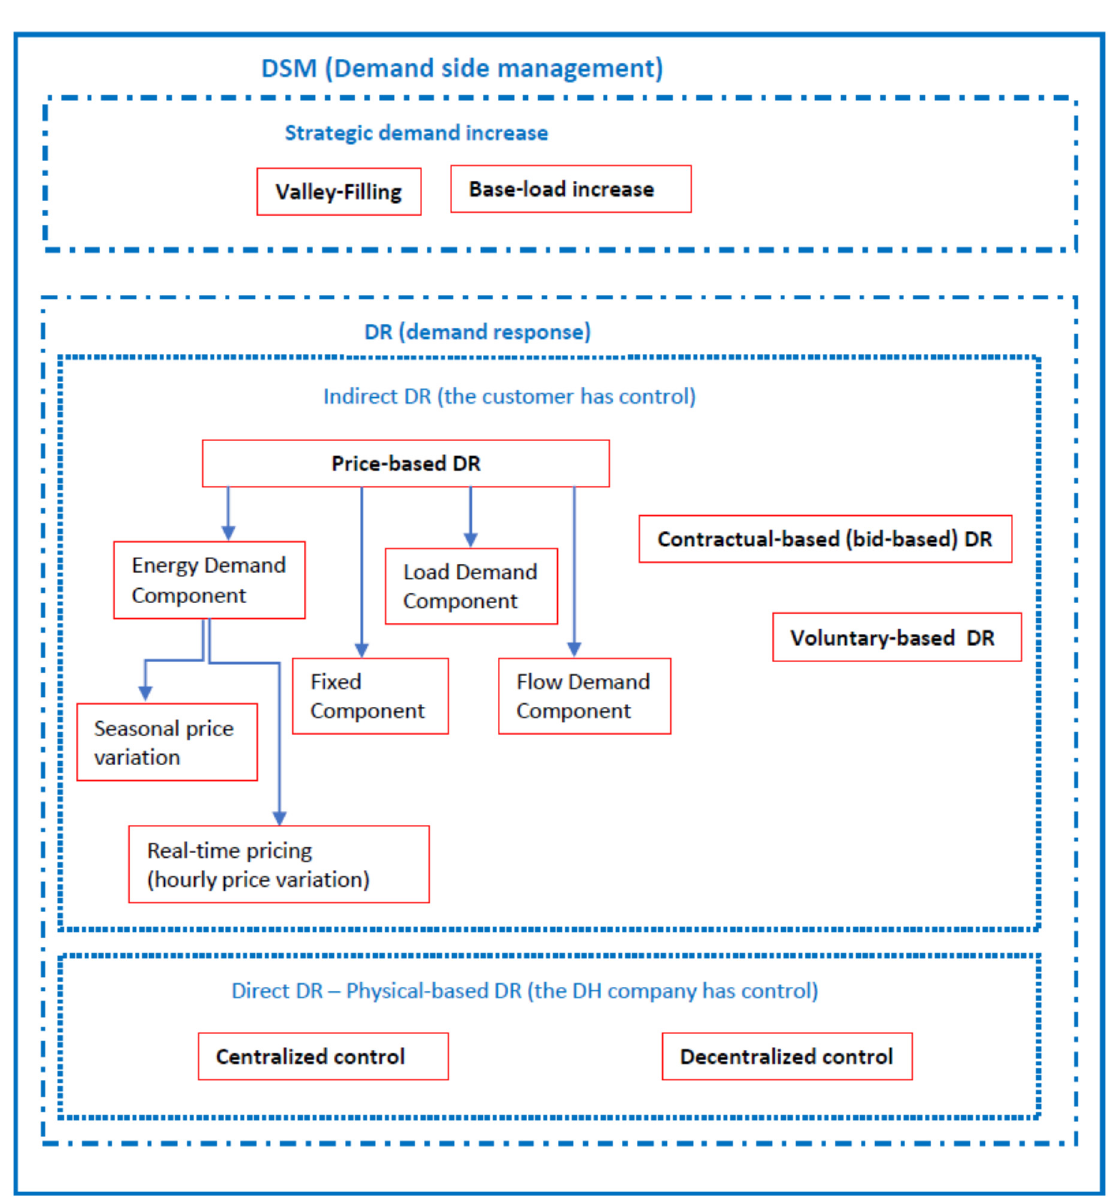
Figure 5. Proposed categorization of demand side measures that are part of DH load variation management.